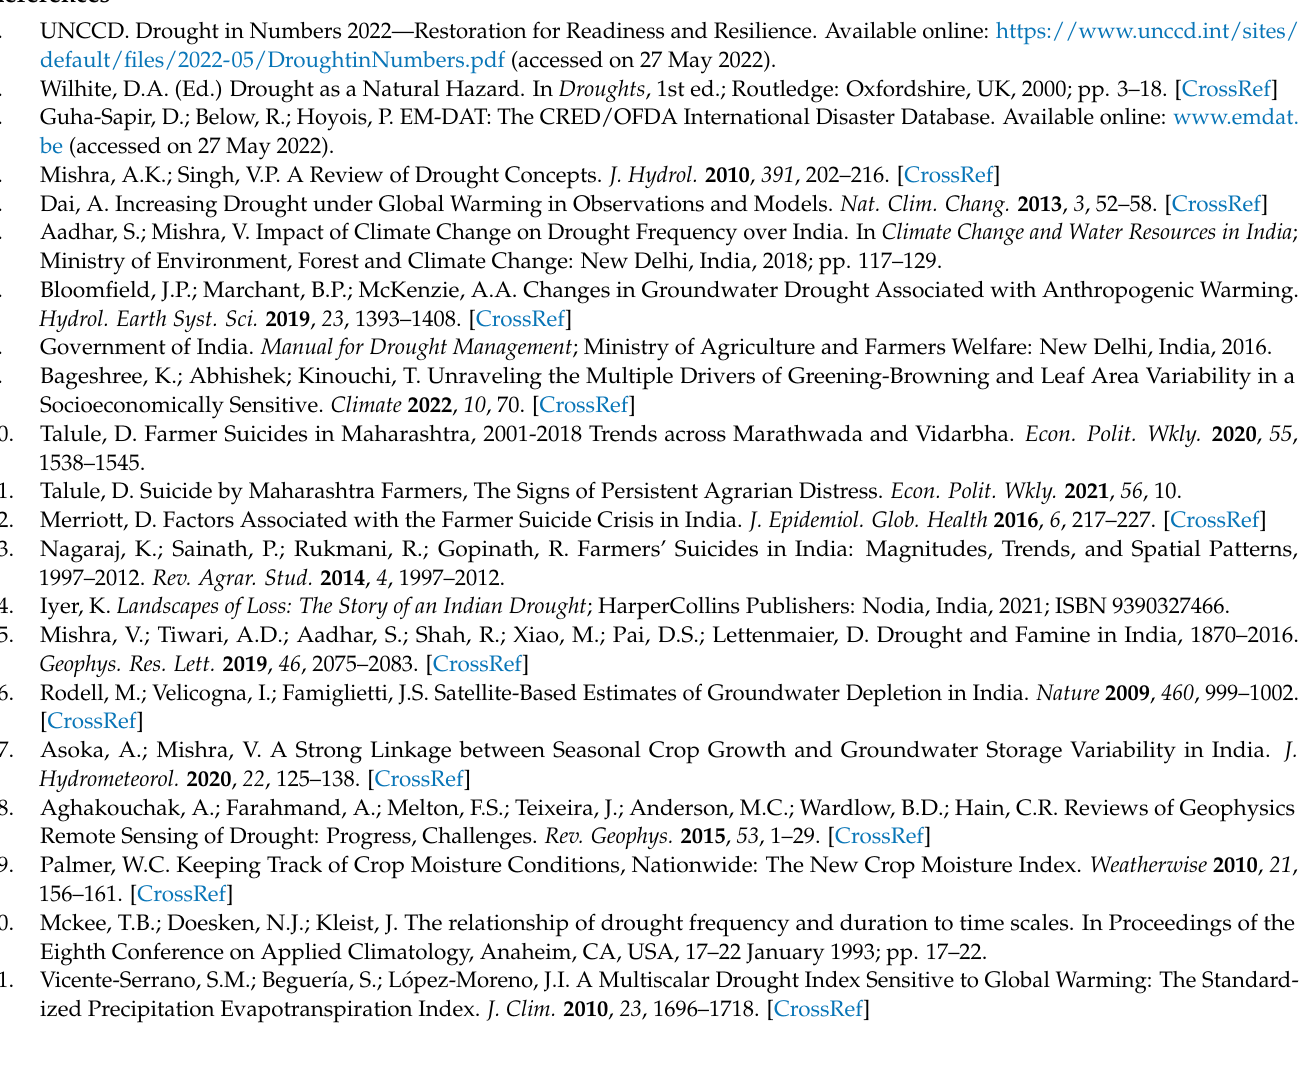
Table S3: Seasonal weights of indices for JDI_PCA in Kharif (scale 3_1_1_3) and Rabi (scale 6_1_1_4) season; Table S4: Correlation between JDI_PCAs having different combinations of the integrated indices; Table S5: Correlation between JDI_Copulas having different combinations of the integrated